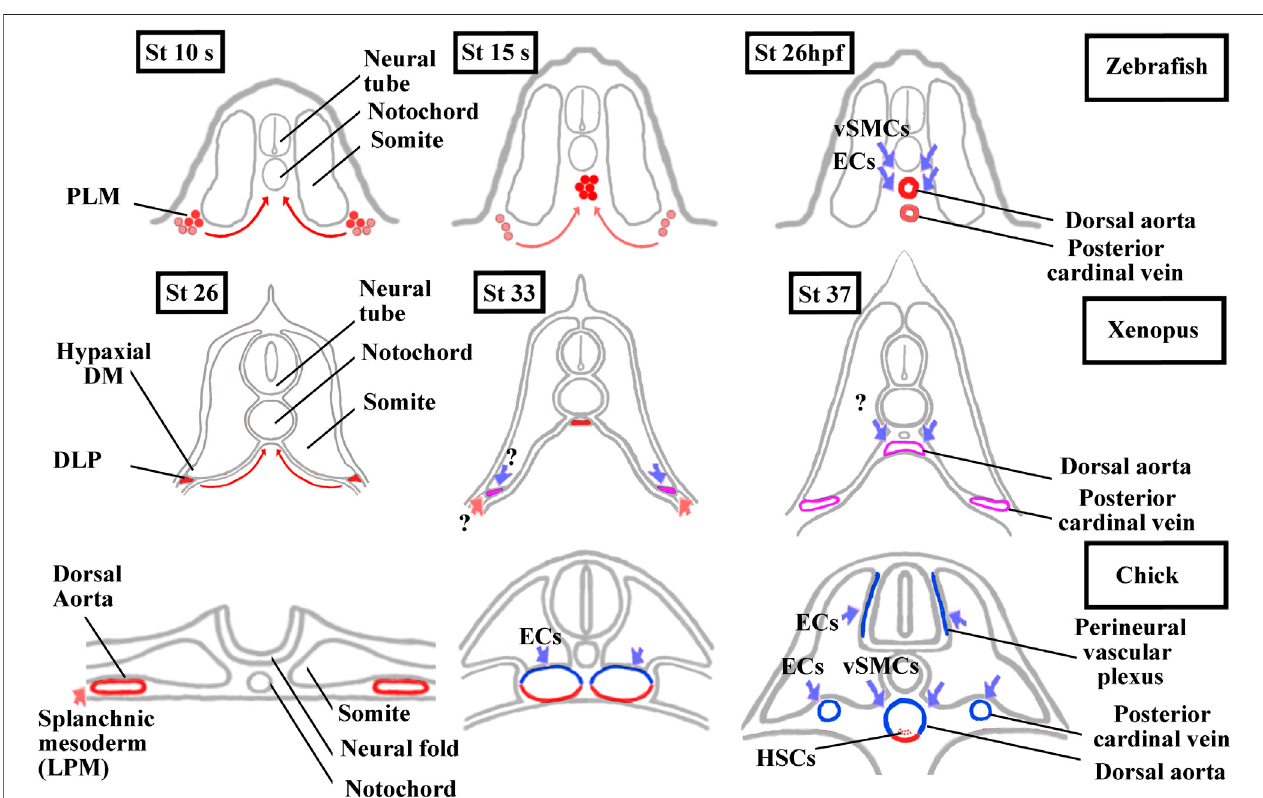
FIGURE6| Comparisonofaortaandposteriorcardinalveinformationandtheirsomiticcontributionsbetweenzebra fi sh, Xenopus, andchick.TheECsandvSMCs that make up the blood vessels throughout the body have various origins. While ECs are exclusively from the splanchnic or the somitic mesoderm, vSMCs are derived from the neural crest and, from the splanchnic or the somitic mesoderm (Pardanaud et al., 1996; Pouget et al., 2006 and, 2008; Etchevers et al., 2001). The aorta formation has also been the focus of intense research in vertebrates as the adult hematopoietic stem cells are generated from the ventral aortic hemangioblasts. Thisbipotent progenitorscanalsodifferentiateintoendothelialcells(Pardanaudet al.,1996;Pardanaudand Dieterlen-Lièvre, 1999;Ciau-Uitzetal.,2010;Ciau-Uitzand Patient, 2016). In zebra fi sh, the aorta hemangioblasts are the fi rst to migrate from the PLM to the midline, coalesce, and form the single aorta. A distinct population of endothelial cells migrates later from the PLM to the midline to form the posterior cardinal vein. ECs and vSMCs from the somites contribute to the aorta and probably to the posterior cardinal vein maturation. Modi fi ed from Kohli et al. (2013) and Hogan and Schulte-Merker (2017). In Xenopus , a single aorta is also made up of migrating hemangioblastsfrom DLP,whereasapair ofbilateralcardinal veinsappears attrunk level.Untilnow,thesomiticcontributionstotheaortaandbilateralcardinal veinsare unknown. Modi fi ed from Cleaver and Krieg, (1998), Ciau-Uitz et al. (2000), and Charpentier et al. (2015). In chick, a pair of bilateral aorta is fi rst formed from the lateral plate mesoderm before fusing at the midline and receiving ECs and vSMCs from the somites. The bilateral posterior cardinal veins are formed of ECs from the somites. The endotome remains dif fi cult to characterize in amniotes since it seems that ECs derive from several somitic regions (Wilting et al., 1995; Nimmagadda et al., 2005). Modi fi ed from Sato, (2013) and Jaffredo et al. (2013). In red, lateral plate mesoderm derived cells. In blue, somite-derived cells. In purple, unknown origin. DLP, dorsal lateral plate mesoderm; DM, dermomyotome; ECs endothelial cells; HSCs, hematopoietic stem cells; LMP, lateral plate mesoderm; PLM, posterior lateral plate mesoderm; vSMCs, vascular smooth muscle